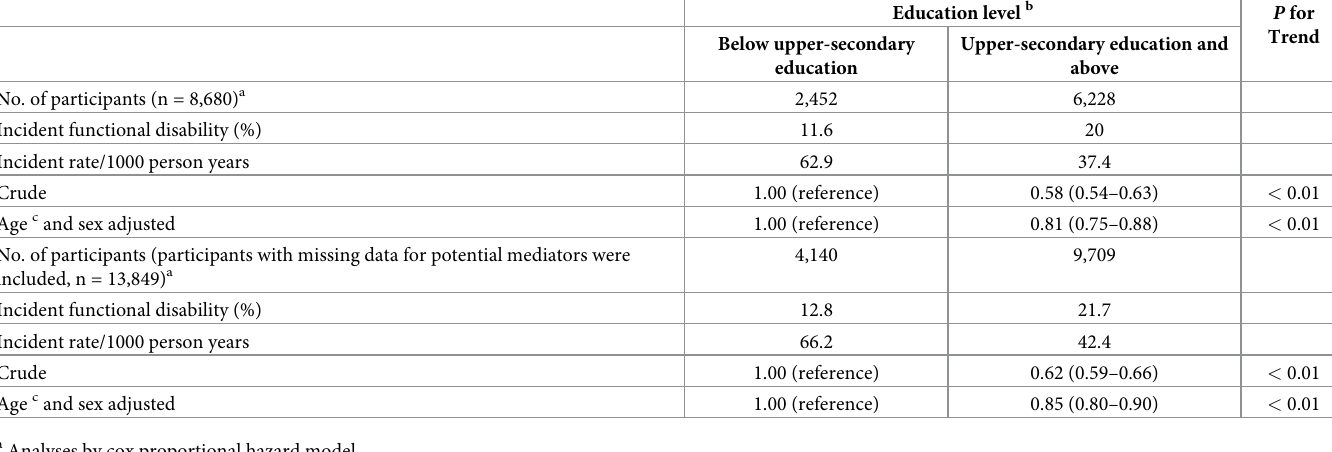
Table 2. Relationship between education level and incident functional disability. Ohsaki city, Japan, 2006–2015.